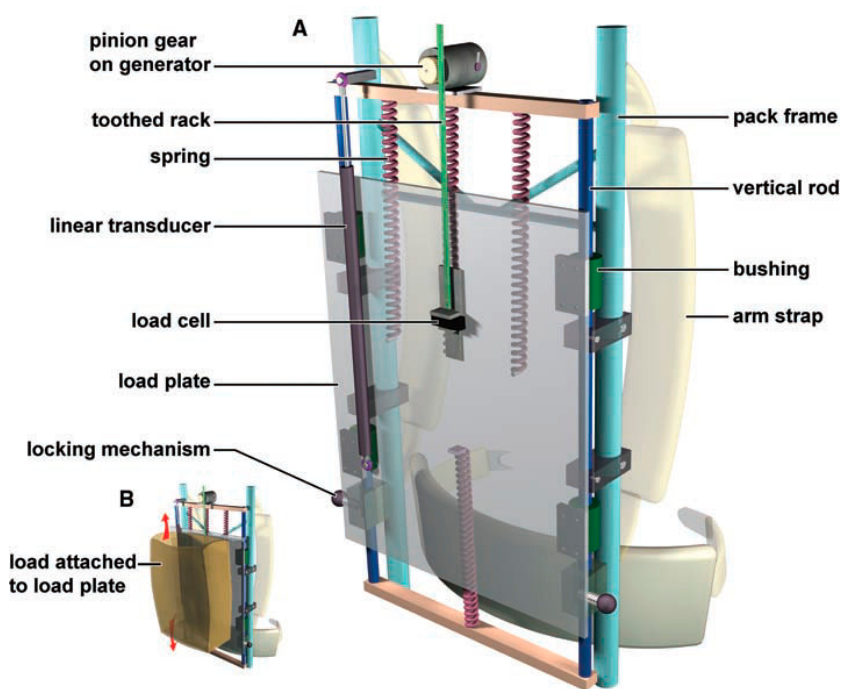
Figure 2. Backpack energy harvester: The pack frame is fixed to the body, but the load, mounted on the load plate, is suspended by springs (red) from the frame (blue): ( A ) During walking, the load is free to ride up and down on bushings along vertical rods; ( B ) [40]. Reproduced with permission from the American Association for the Advancement of Science.